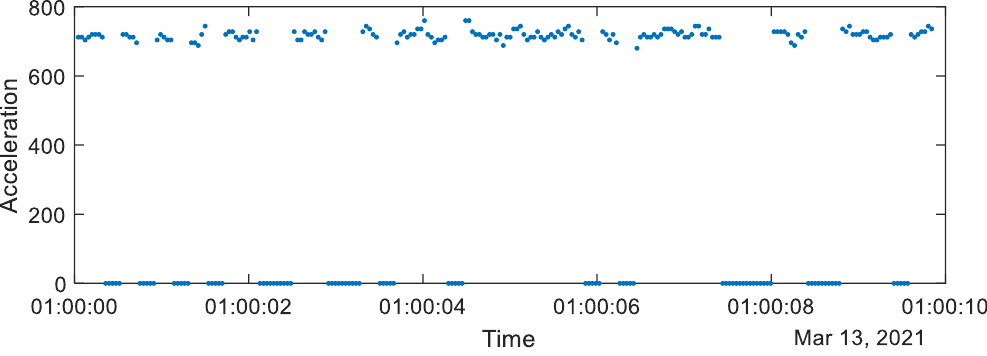
Figure 3. Illustration of the missing samples (value 0) in the recorded acceleration data (dots).